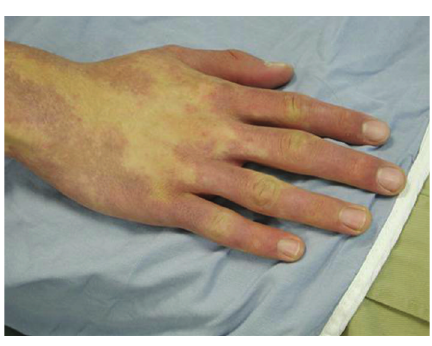
Figure 3: Capillary malformation, Rt. Hand.